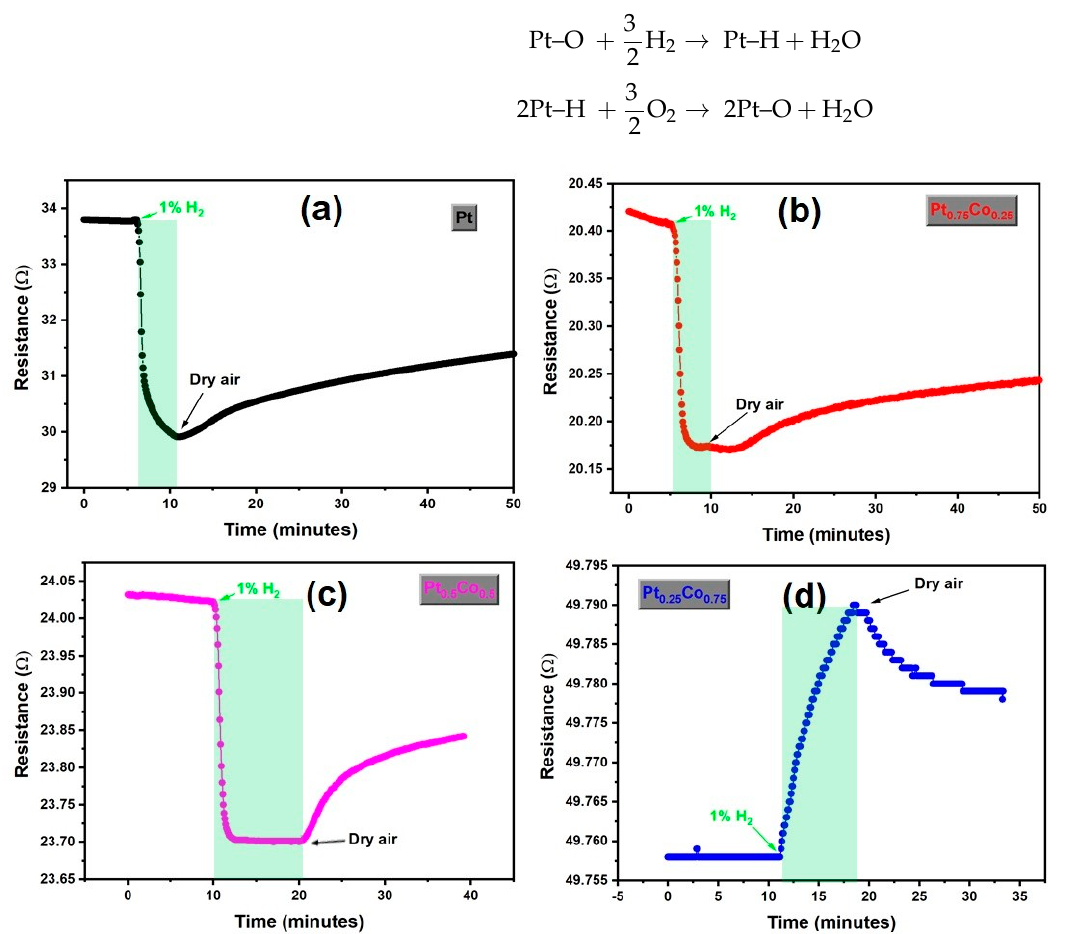
Figure 4. The resistance over time for ( a ) pure Pt, ( b ) Pt 0.75 Co 0.25 , ( c ) Pt 0.5 Co 0.5 , and ( d ) Pt 0.25 Co 0.75 thin film samples, upon injection of H 2 and air at room temperature.